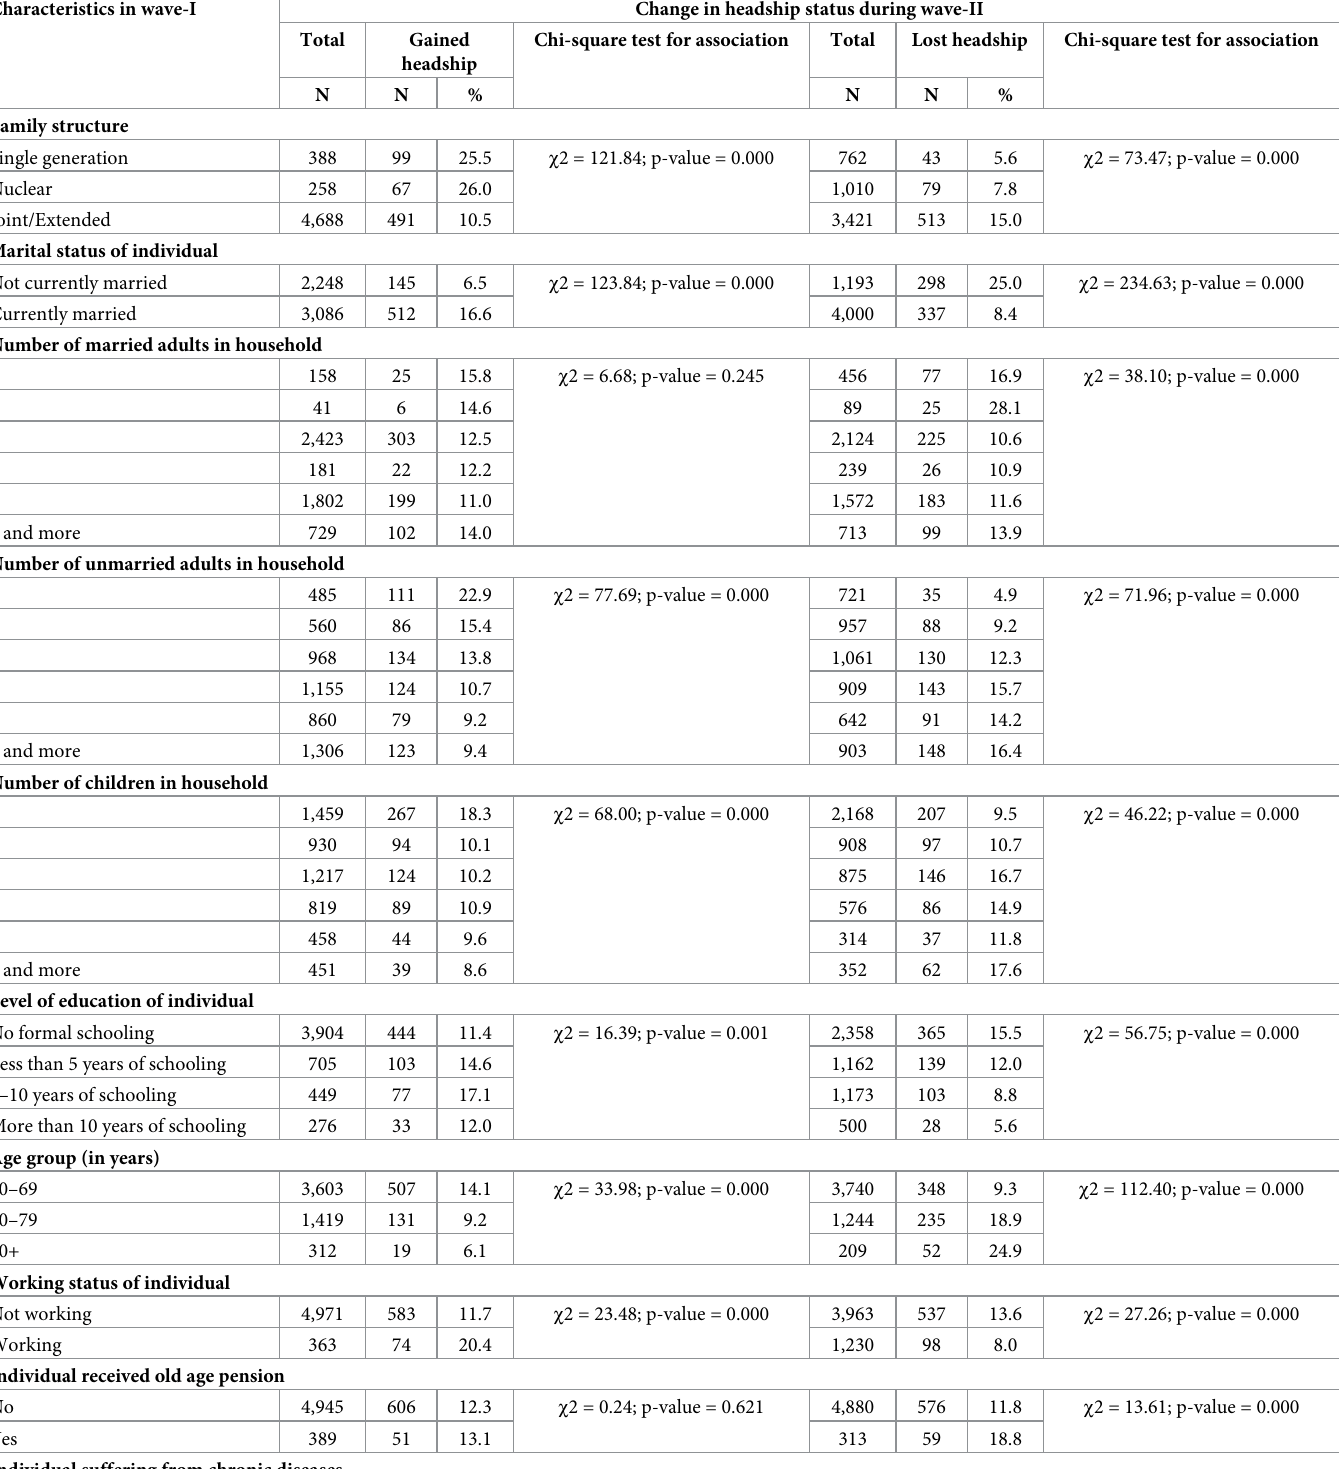
Table 2. Bivariate analysis showing the association of socio-economic and demographic in wave-I with the gain and loss of headship in wave-II. Characteristics in